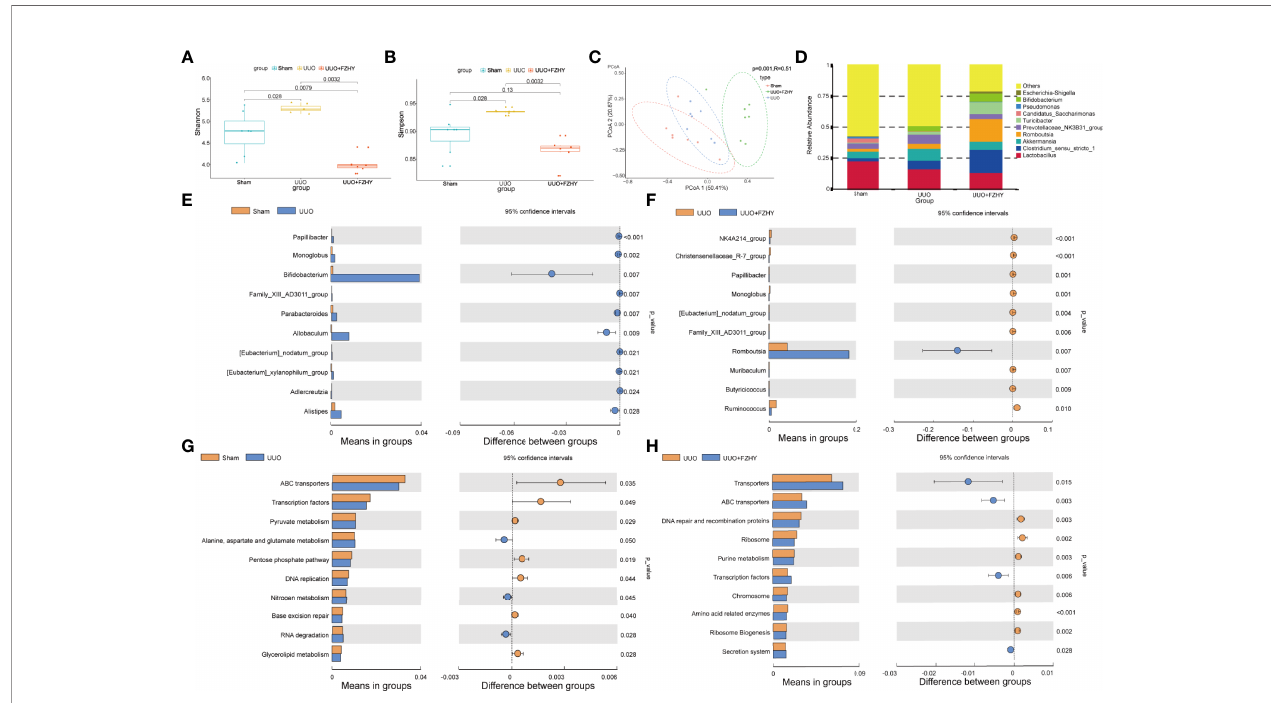
FIGURE 3 | Diversity and abundance analysis. The alpha diversity [Shannon (A) , Simpson (B) ] based on operational taxonomic unit (OTU) abundance for the sham, UUO, and UUO+FZHY groups. (C) The beta diversity shows the PCoA plot of UniFrac distances. (D) The top 10 high relative abundance for the sham, UUO, and UUO+FZHY groups. The difference of abundance at the genus level in the sham group compared with the UUO group (E) and the UUO group compared with the UUO+FZHY group (F) . The difference of abundance at the genus level in the sham group compared with the UUO group (G) and the UUO group compared with the UUO+FZHY group (H) . Wilcoxon rank-sum test was used to compare the difference in diversity between the two groups in the boxplot. t -test was used to compare the difference in abundance between the two groups; P < 0.05 is considered to be a signi fi cant